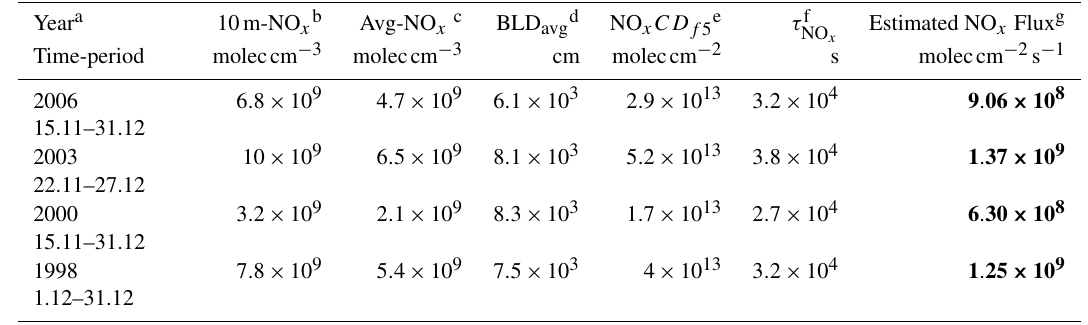
Table 2. Assessment of ISCAT/ANTCI NO x flux at SP for BL concentration fall-off of factor of 5. Estimated fluxes are in bold. Year a